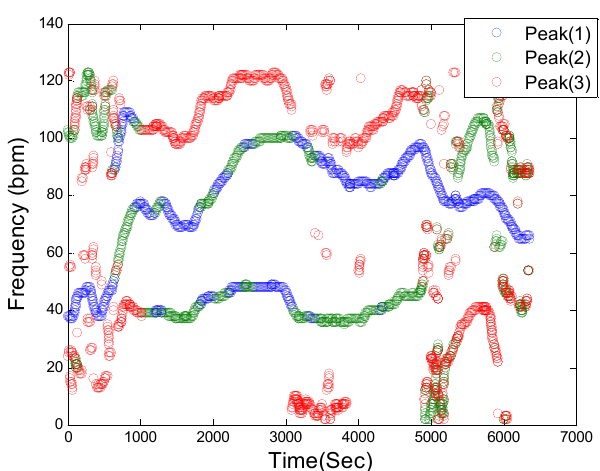
Figure 2. Spectral filtering. PPG time-frequency spectrum: Blue, Green and Red circles correspond to the first three highest peaks in the defined HR frequency range of (30–180 bpm), respectively, at each sliding window.